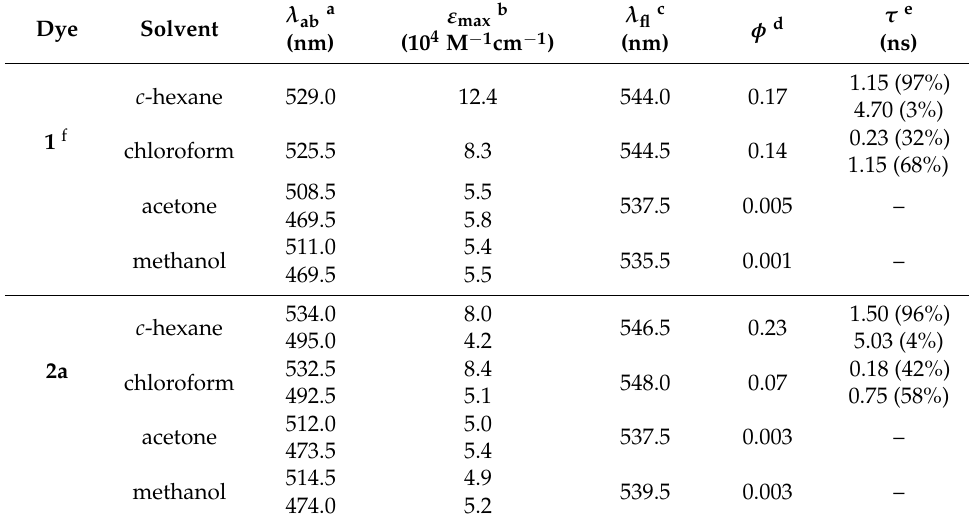
Table 1. Comparative spectroscopic data for 1 and 2a in different solvents ( ca. 10 − 6 M).